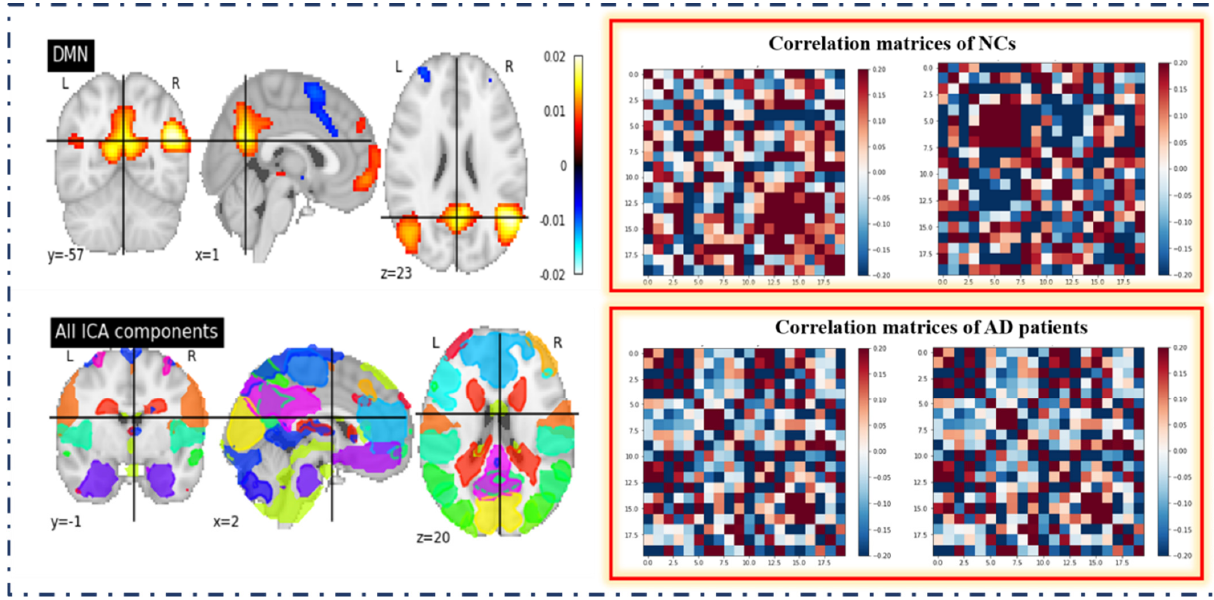
Figure 5. DMN and ICA components and Correlation matrices using ICA for NC and AD patients.